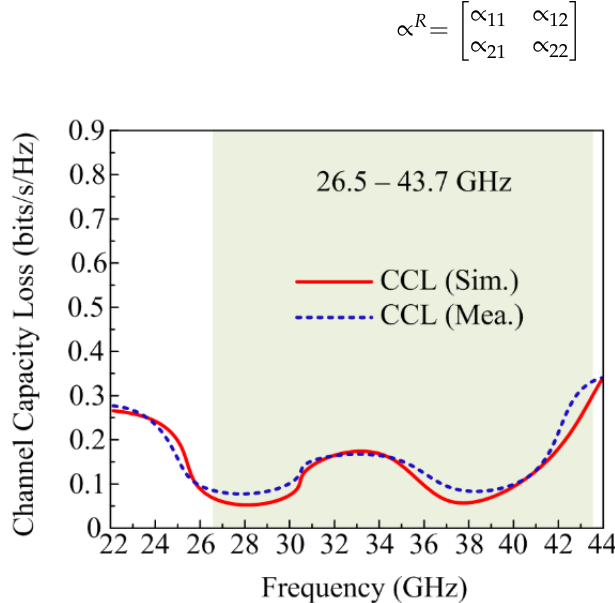
Figure 16. CCL of the proposed work.